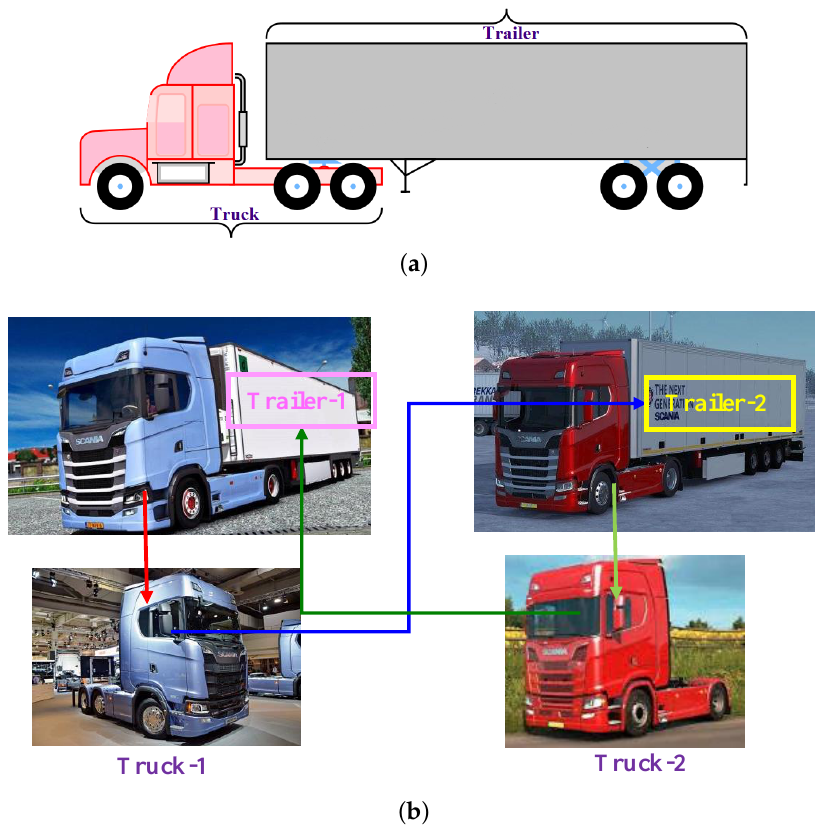
Figure 10. ( a ) Loading/unloading operations at the intermediate exchange points can be greatly reduced by the use of decoupled trucks and trailers. ( b ) At the transfer points, the trucks (along with the drivers) and the trailers can be decoupled, and Truck 1 can be assigned to Trailer 2 and vice versa. In this way, the loading/unloading operations at the exchange points can be